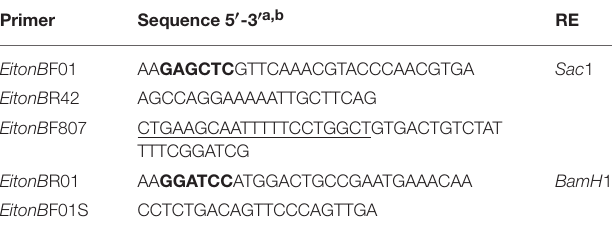
TABLE 1 | List of primers with restriction enzyme used to construct Ei 1 tonB